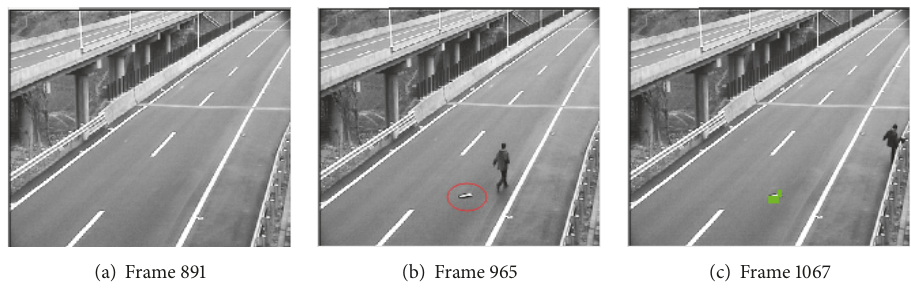
Figure 10: Detection results of the droppings on Chongqing